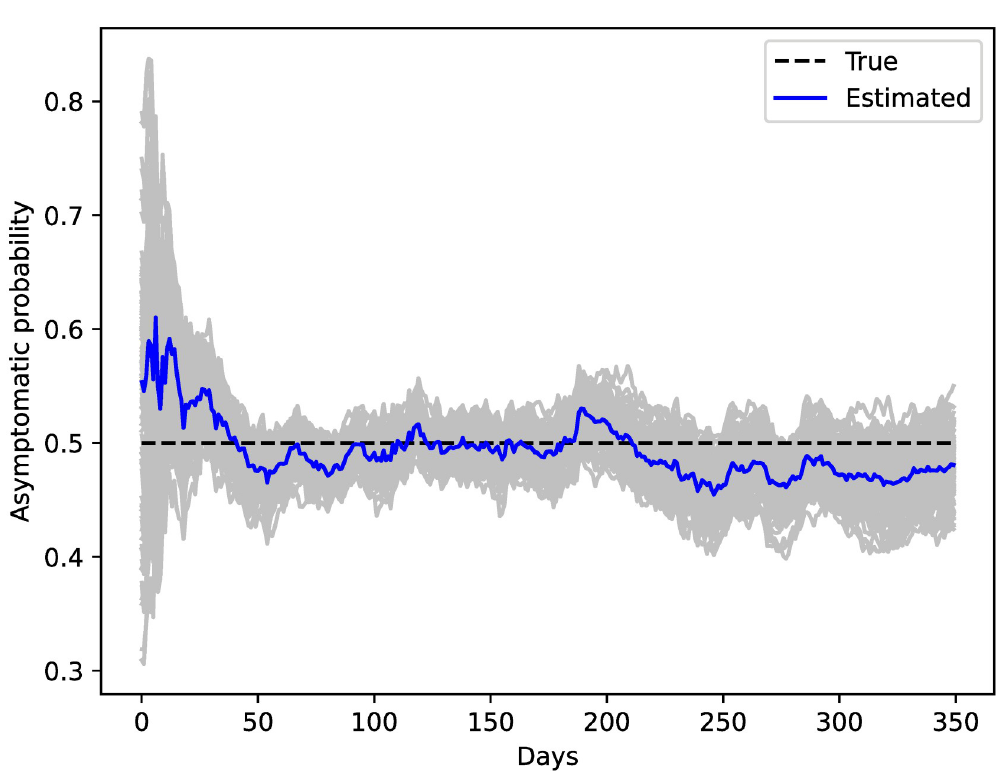
Fig 9. Estimations of the asymptomatic rate. The mean of estimation of q line, ensemble members with gray lines, and the true parameter value with a black dashed line.